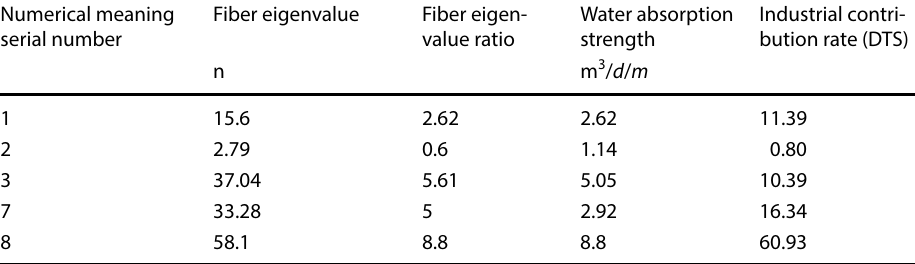
Table 4 Comparison of fiber optic interpretation and conventional interpretation